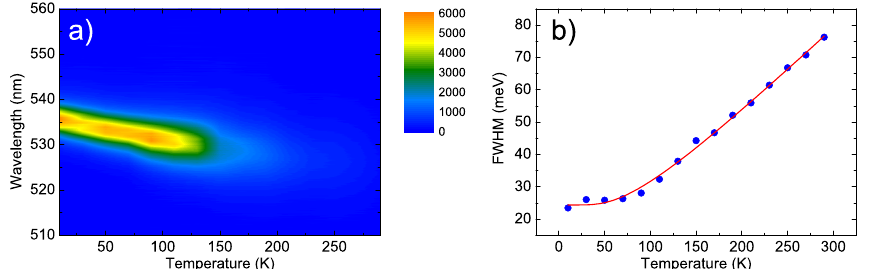
Figure 6. ( a ): Two-dimensional map of the temperature dependence of the PL of the bulkCsPbBr 3 polycrystalline thin film. ( b ): Temperature dependence of the FWHM of the PL spectra of the same sample (dots) and the best fit with Equation